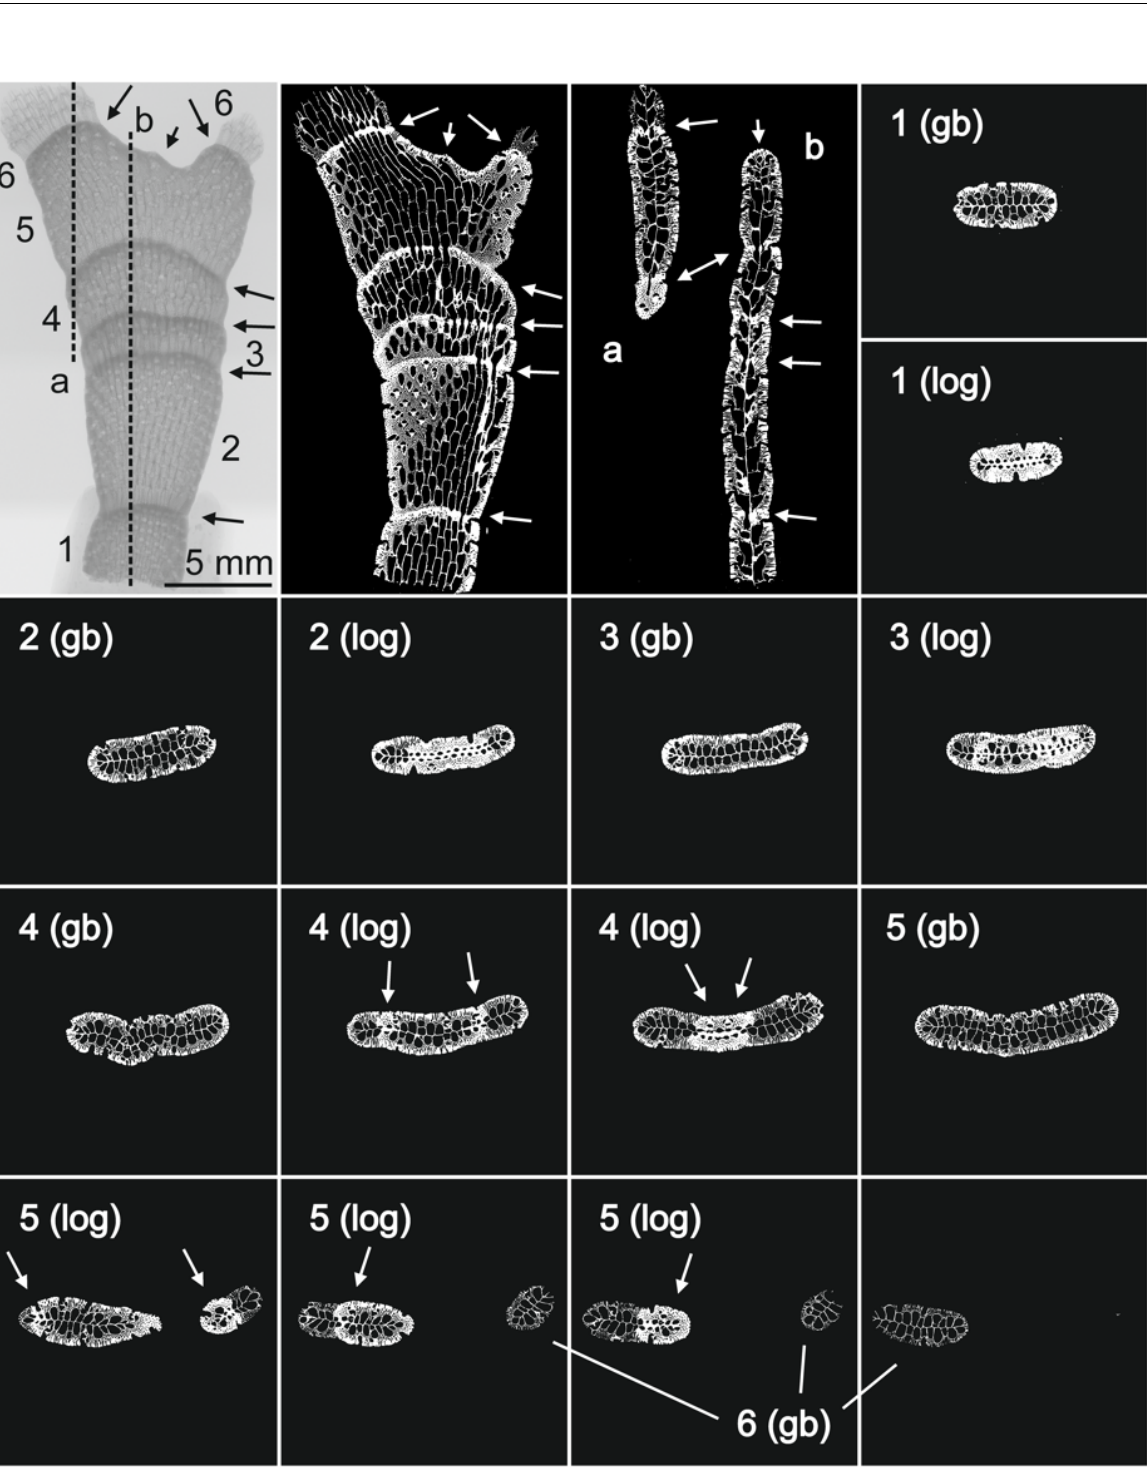
Figure 6. Micro CT images of Cellarinella njegovanae . Radiographic image of the whole branch (scale bar: 5 mm) showing the growth bands ( 1 – 5 ) (arrowed) and two branch axes ( a , b ) for longitudinal sections. Band 6 corresponds to the growing edge. Frontal and lateral ( a , b ) longitudinal sections of the whole branch; 14 transverse sections corresponding to the growth bands (gb) ( 1 – 5 )and growth check lines (gcl) (arrowed) ( 1 – 5 ). Scale bar micro CT images: 5